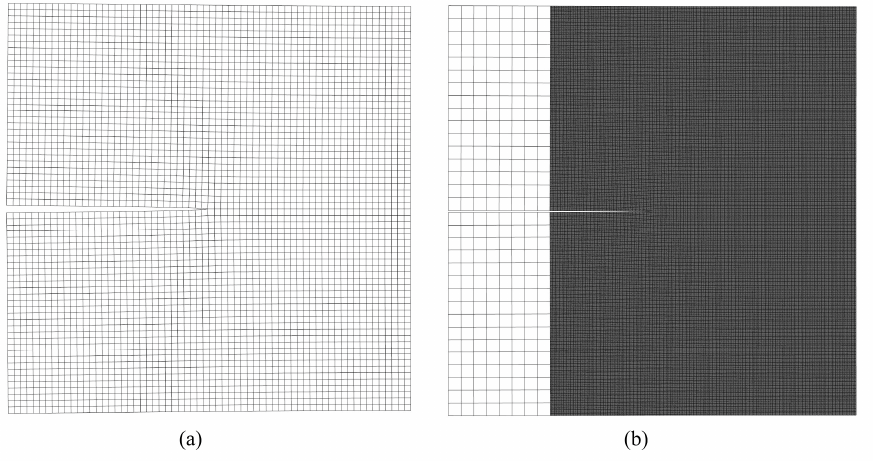
Figure 10. ( a ) Deformed mesh around the crack tip from the view of highest refinement level (in this view, the size of the largest element is 0.003125 mm × 0.003125 mm); ( b ) Deformed mesh around the crack tip from the view of the 6th refinement level (in this view, the size of the largest element is 0.0625 mm × 0.0625 mm).